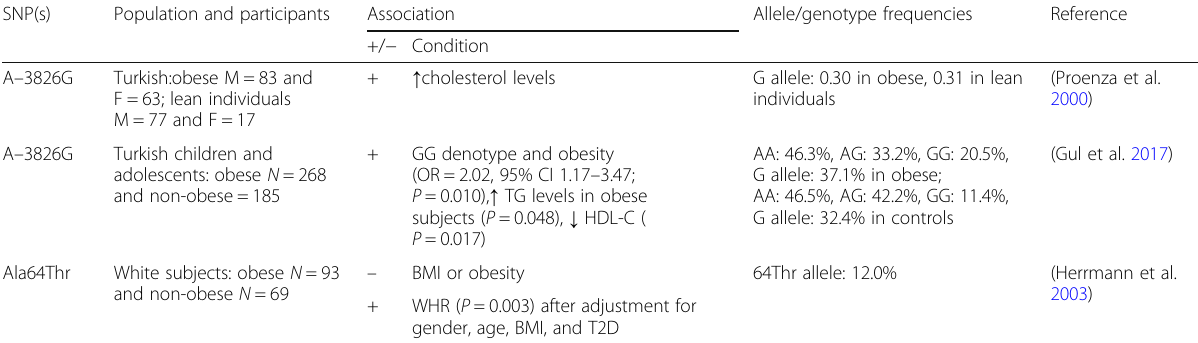
Table 1 Studies on the association between the Ucp1 polymorphisms and CMDs or CMD risk factors in different populations (Continued) SNP(s)